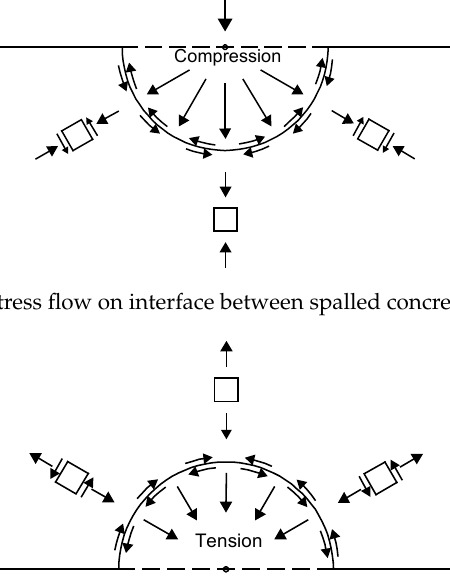
Figure 4. Stress flow on interface between scabbed concrete and a slab.